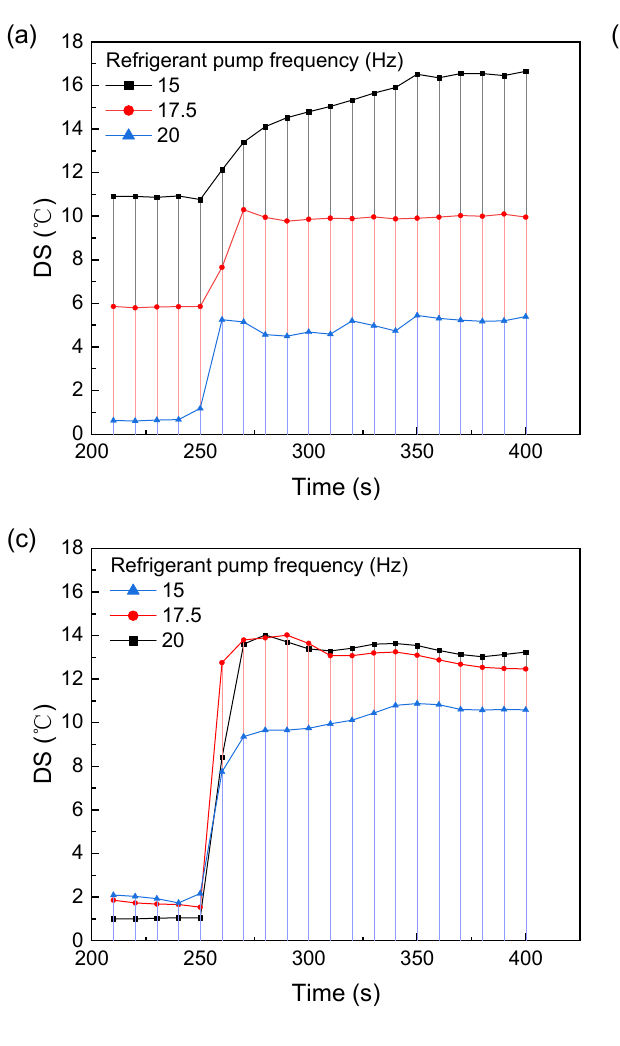
Figure 6. The change curves of DS when the EXV1 opening is adjusted from 30% to 10% ( a ) the refrigerant pump opening is 40%; ( b ) the refrigerant pump opening is 60%; ( c ) the refrigerant pump opening is 80%. As can be seen from Figure 6, when the refrigerant pump opening is 40%, 60%, and 80%, the refrigerant pump frequencies corresponding to the fast response of the DS and its early stabilization time are 20 Hz, 17.5 Hz, and 15 Hz, respectively. Therefore, these three sets of data are selected for the self-tuning, as shown in Figure 7. According to Figure 7 and the empirical formula of Ziegler-Nichols [36], the character- istic parameters of the DS, as well as the corresponding proportional adjustment coefficients K p and integration time constants T i of the PI control algorithm, can be derived under different conditions, as shown in Table